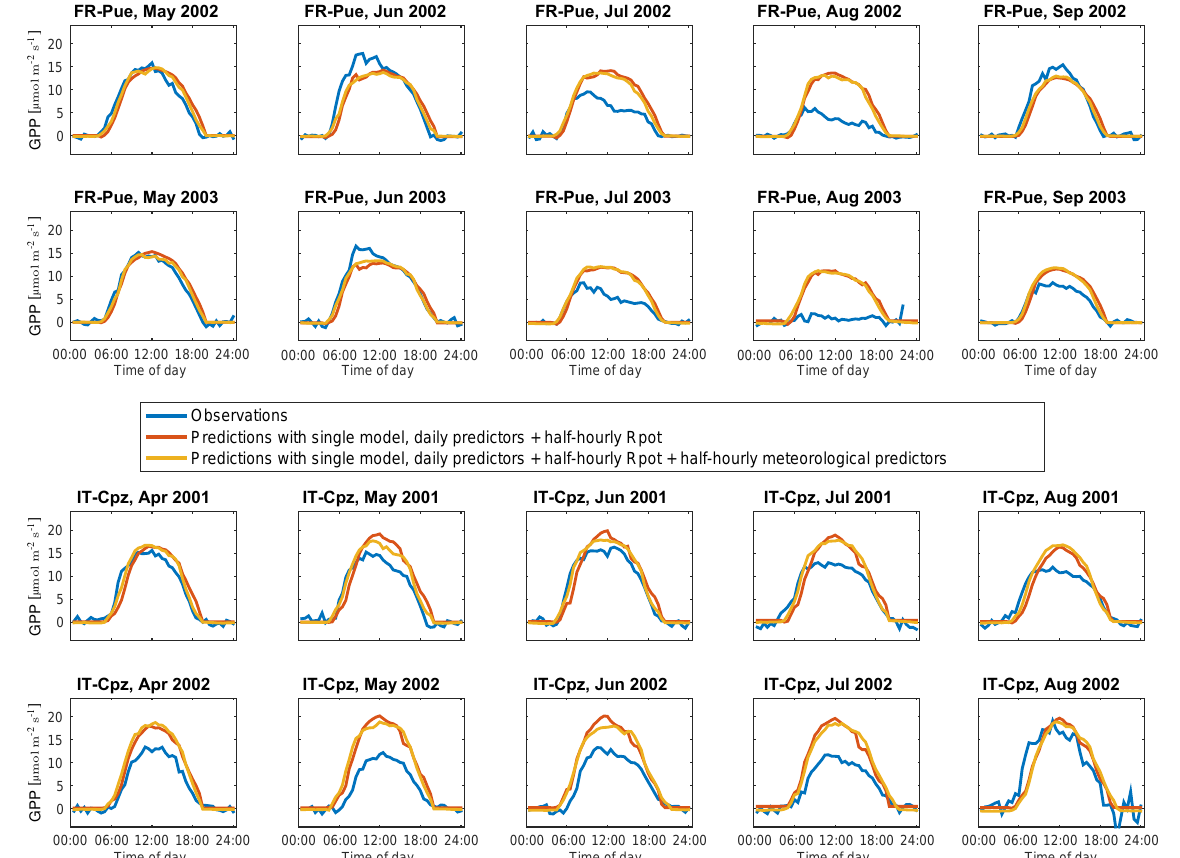
Figure 9. Average diurnal cycles of two sites showing the problems with seasonal droughts. The error in the prediction of the half-hourly fluxes increases during hot and dry summers for both sites, FR-Pue and